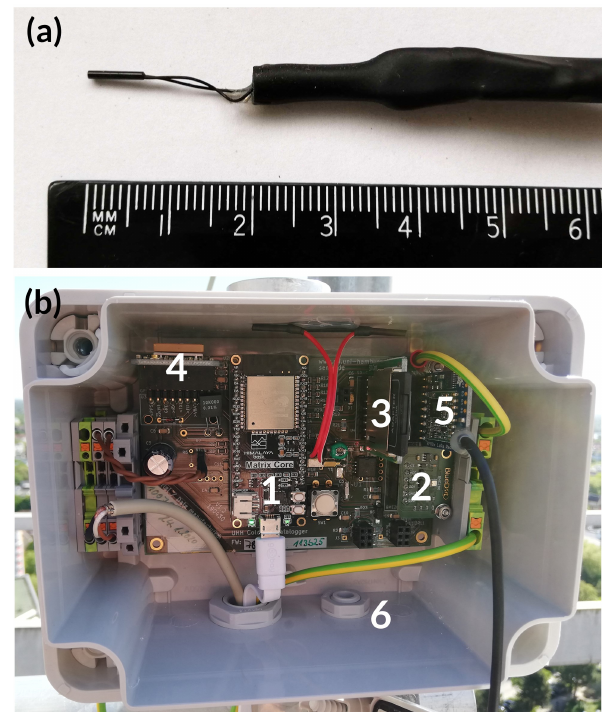
Figure 2. (a) NTC thermometer with scale for reference and (b) logger main board of APOLLO station. Marked are the micro controller board (1), digital air pressure sensor BME280 (2), micro- SD memory card (3), GPS receiver module (4), long-range (LoRa) module (5), and pressure counterbalance valve